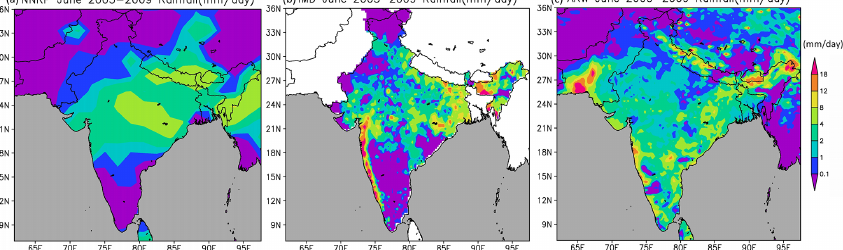
Figure 7. Mean daily precipitation anomaly in the contrasting monsoon years (2003–2009) (mmday − 1 ) from (a) NNRP (b) ARW and (c) IMD gridded rainfall